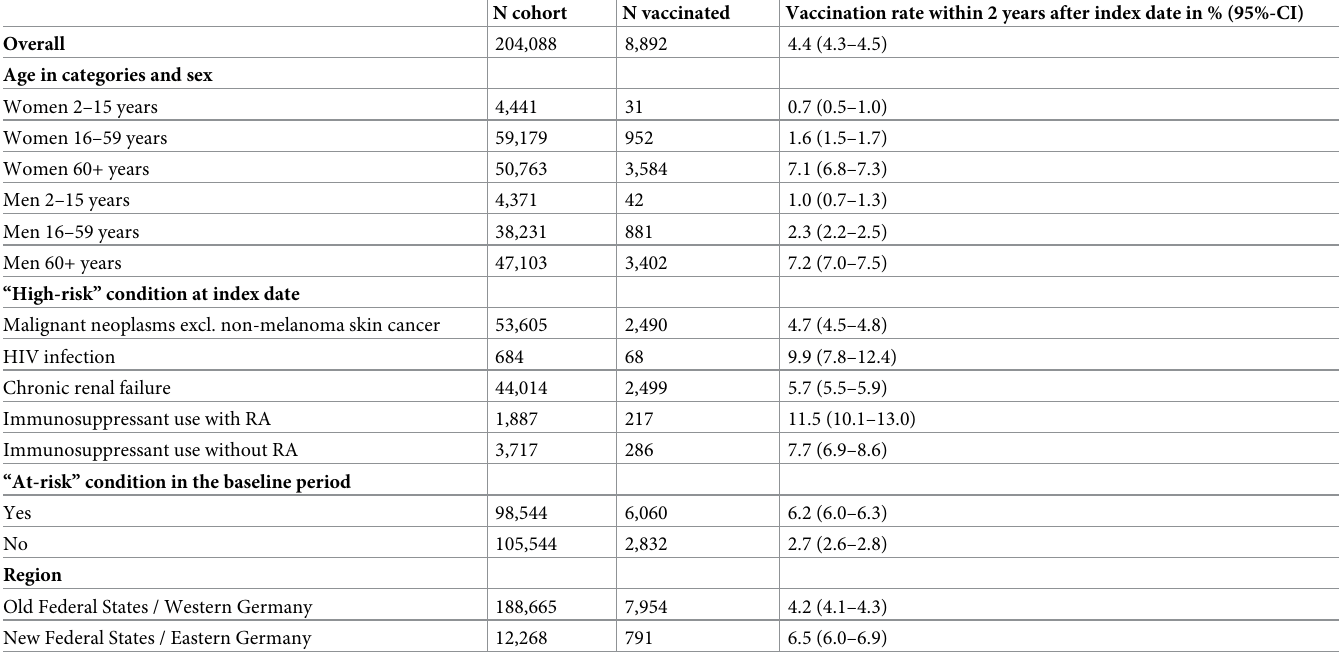
Table 2. Pneumococcal vaccination rates with 95%-confidence intervals within two years in patients with “high-risk” condition for pneumococcal disease.